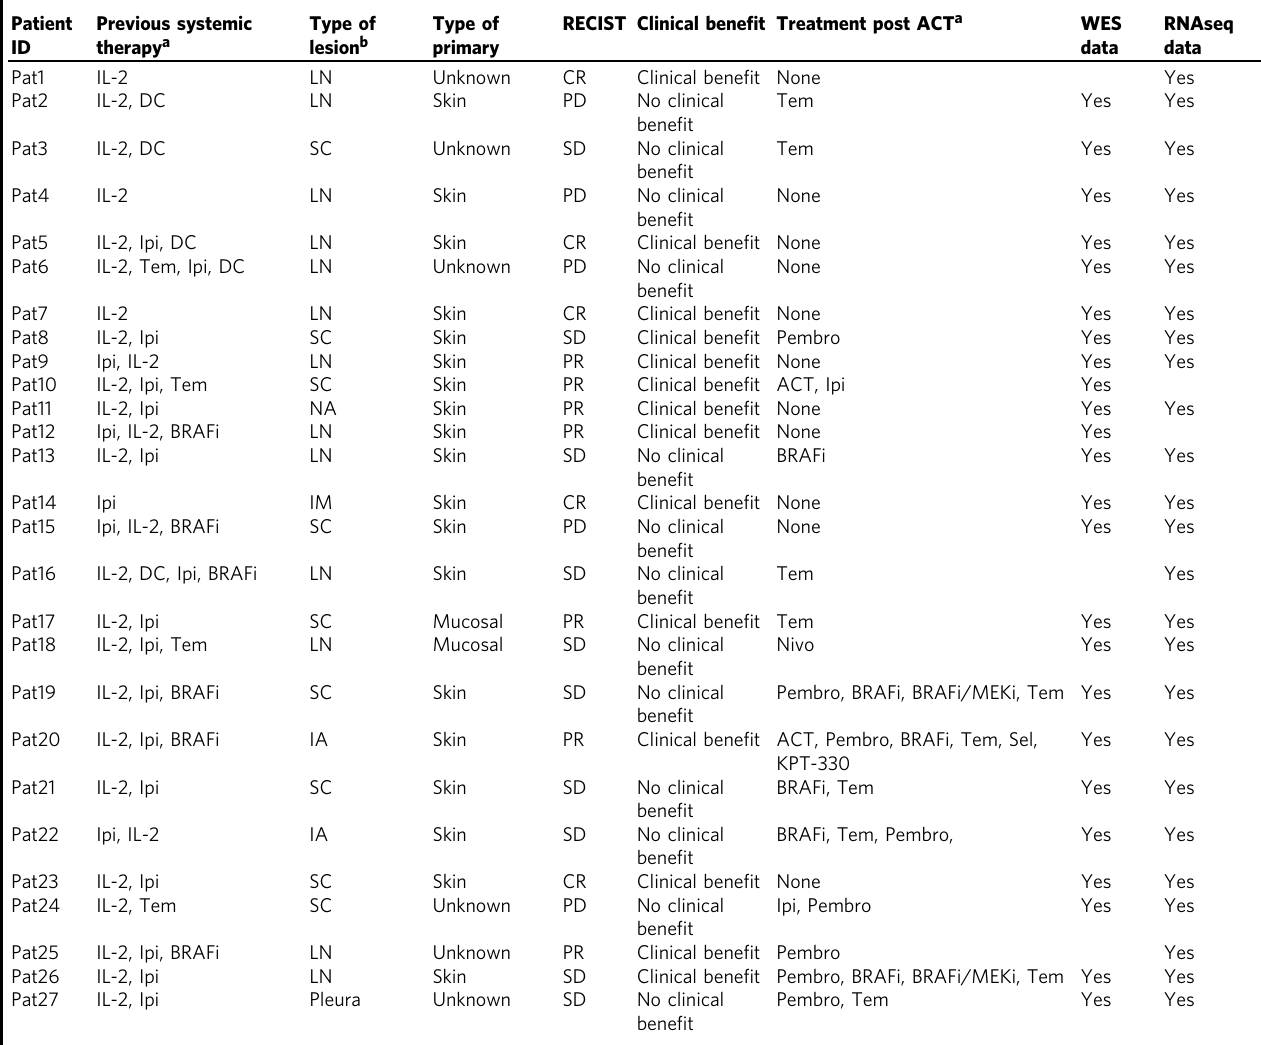
Table 1 Patient characteristics of the analyzed cohort Patient